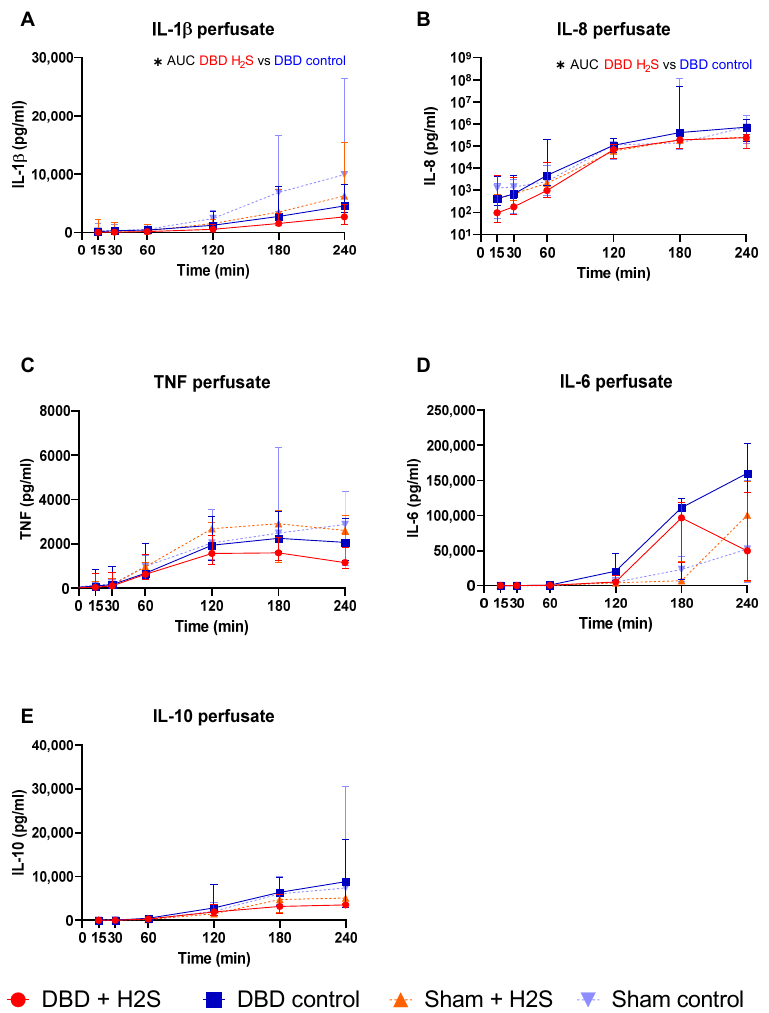
Figure 2. Cytokine release. ( A – E ): respectively IL-1b, IL-8, TNF IL-6, and IL-10 levels (pg/mL) in the perfusate during NMP. Data presented as median + interquartile range. * p < 0.05. Abbreviations: AUC = area under the curve. TNF = tumor necrosis factor. NMP = normothermic machine perfusion.